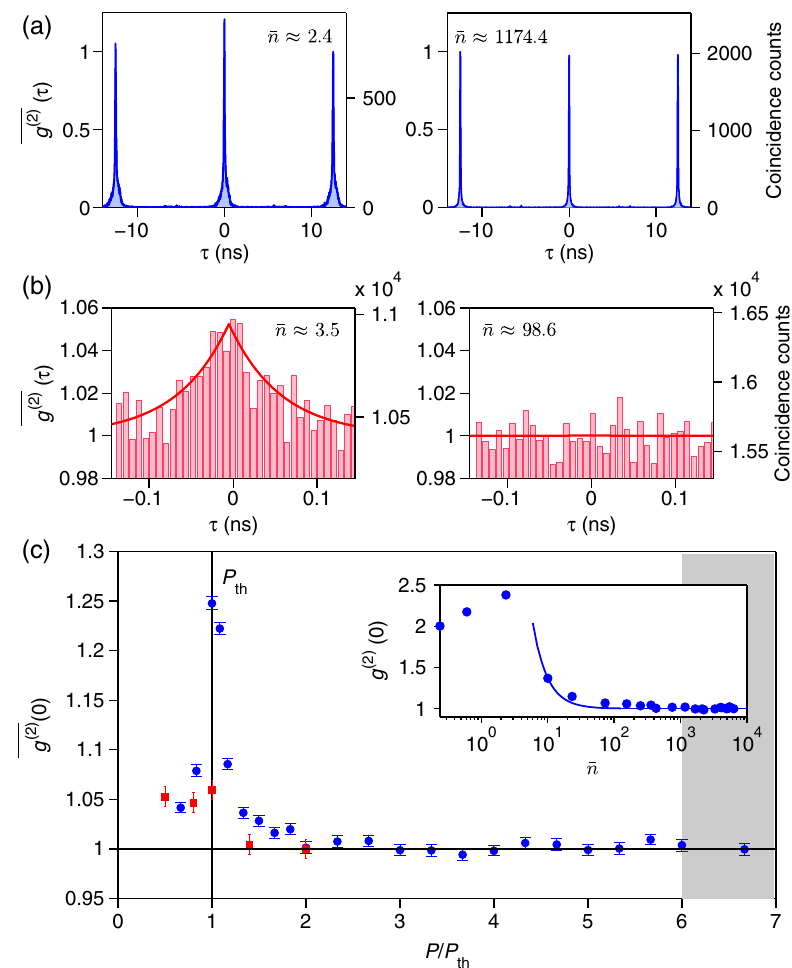
FIG. 3. Second-order coherence properties of the single-mode polariton laser. (a) g ð 2 Þ ð τ Þ vs τ below and above the threshold for pulsed for pulsed (dots) and CW (rectangles) excitation. (b) g ð 2 Þ ð τ Þ vs τ below and above the threshold for CW excitation. (c) g ð 2 Þ ð 0 Þ vs P=P th excitations. The error bars indicate statistical error of 1 standard deviation. The grey-shaded area shows where the polariton and photon lasing coexist. Inset: g ð 2 Þ ð 0 Þ vs ¯ n of pulsed excitation corrected for the relaxation time of the ground state [40]. The solid line shows a ¼ 37 . 3 (cid:2) 0 . 9 theoretical fit by Eq. (2), yielding n s